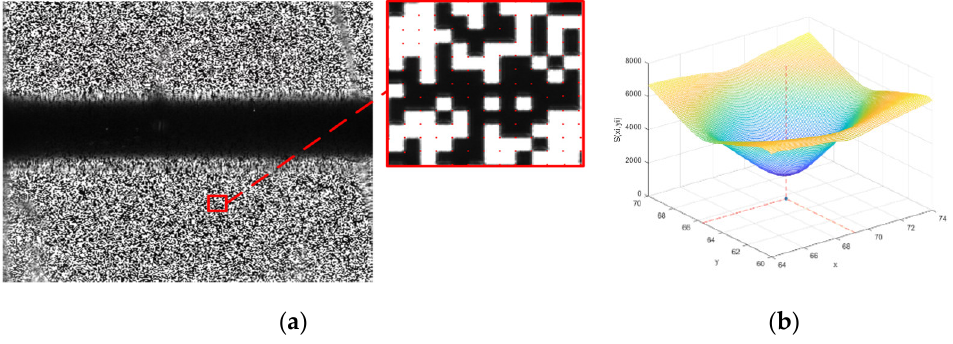
Figure 8. Actual picture of M-array photo-etching glass plate. Part I is the assembly area; part II is the M-array coding area, and the workpiece is placed in the coding area for the transformation of absolute coordinates.